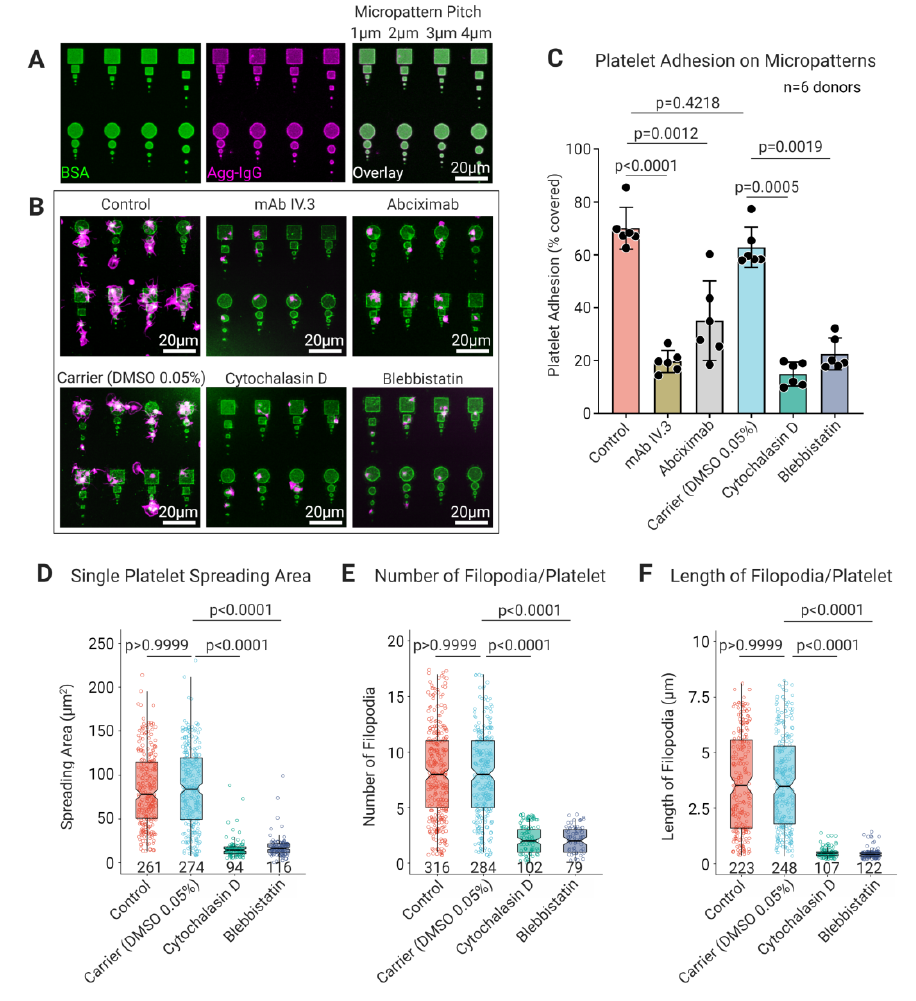
Figure 1. Specific recognition of Agg-IgG on micropatterns depends on platelet Fc γ RIIA mediated interactions, and cytoskeletal integrity is necessary for platelet adhesion and spreading. ( A ) CLSM images of micropatterned arrays of bovine serum albumin (BSA 4%) spiked with 1% BSA-FITC (in green) fabricated using electron beam lithography with different sizes inter-pattern pitch distances. Micropatterns were functionalized by covalent conjugation of heat aggregated human IgG (Agg- IgG detected using goat anti-human IgG Alexa 555 in magenta) to BSA in a one-step reaction using bifunctional linker 3,3’-Dithiobis(sulfosuccinimidylpropionate) (DTSSP); ( B ) representative confo- cal fluorescence microscopy images; and ( C ) analysis of the effect on platelet adhesion upon of pre- treatment of platelets with FcγRIIA blocking mAb IV.3 (4 μg /mL), integrin αIIbβ3 blocking anti- body, cytochalasin D (25 µM), and blebbistatin (10 µM) shows significant reduction in comparison with untreated platelets (control) and DMSO 0.05% (as carrier) on their spreading on Agg-IgG func- tionalized micropatterns (platelet F-actin in magenta, Agg-IgG detected using goat anti-human IgG Alexa 488 in green). Data represent mean ± SD from n = 6 donors, and statistical comparisons were performed using one-wa y ANOVA , followed by Tukey’s multiple comparisons for spreading area measurements. Inhibition of platelet F-actin polymerization by cytochalasin D (25 µM) and myosin II by ATPase inhibitor blebbistatin (10 µM) significantly reduces ( D ) platelet spreading area, ( E ) filopodia number, and ( F ) their length in single platelets in comparison with untreated platelets (control) and DMSO 0.05% (as carrier) on Agg-IgG functionalized micropatterns. Statistical compar- isons were performed by one-way ANOVA on ranks (non -parametric) followed by Dunn’s multiple comparisons test. Boxplots extend from 10 to 90 percentiles, and p < 0.05 is significant.